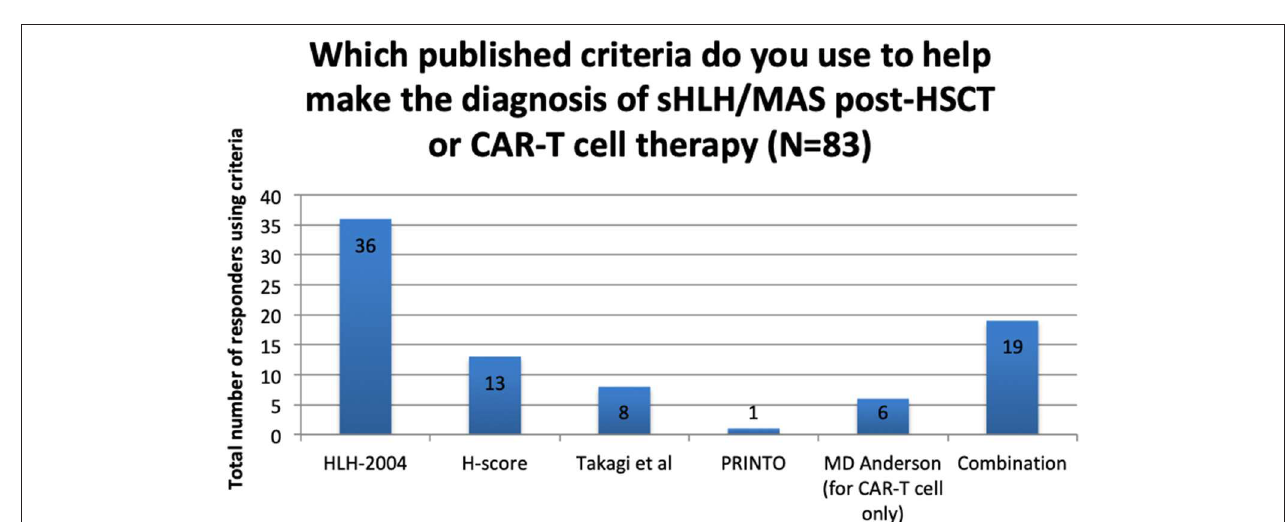
FIGURE 4 | Use of published criteria to support diagnosis of sHLH/MAS post-HSCT or CAR-T cell therapy.